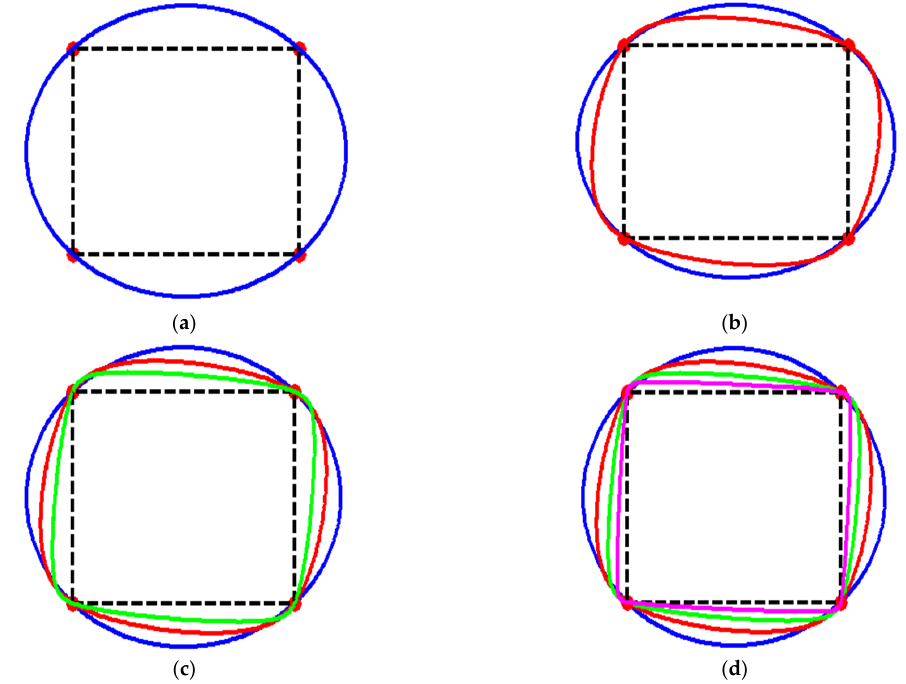
Figure 11. ( a – d ) are RQTS curve through biased tension, by 𝜎 (cid:3036) (cid:3404) 2,3,5 , and 10 ∀ 𝑖 .